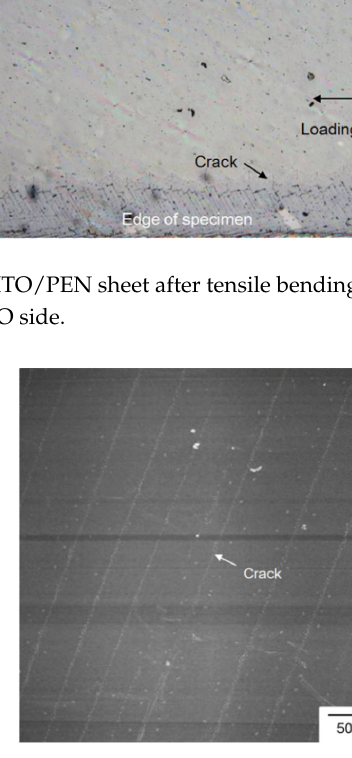
Figure 8. SEM micrograph of ITO/PEN sheet after tensile bending with a 10 mm curvature radius for 1000 h, as viewed from the ITO side.